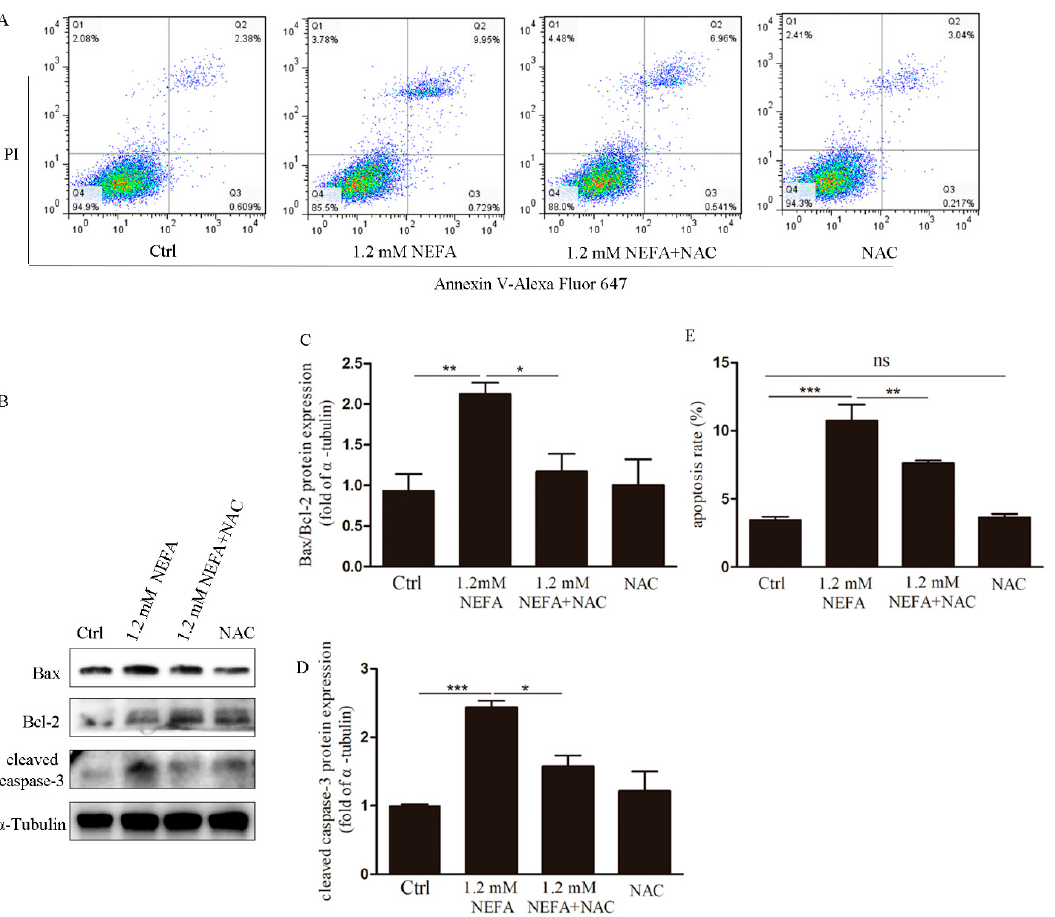
Figure 4. Treatment of NAC in vitro attenuates apoptosis in NEFA treated GCs. ( A , E ) Apoptosis events were determined by FACS analysis after Annexin V-Alexa Fluor 647 / PI staining in the treated GCs. ( B – D ) The results of Bax, Bcl-2, and cleaved caspase-3 protein levels showed that NAC alleviated GCs apoptosis induced by high-level NEFA. Data are presented as mean ± SEM, * p < 0.05, ** p < 0.01, and *** p < 0.001. ns, not